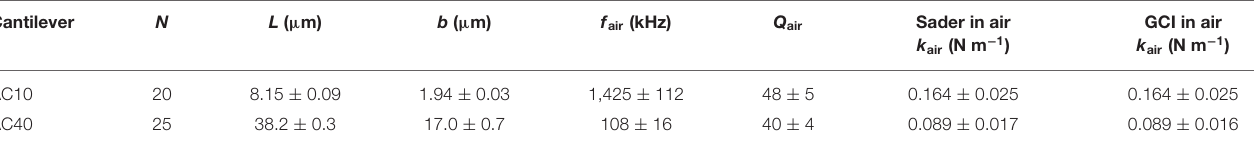
TABLE 1 | Summary of the cantilever parameters in air.